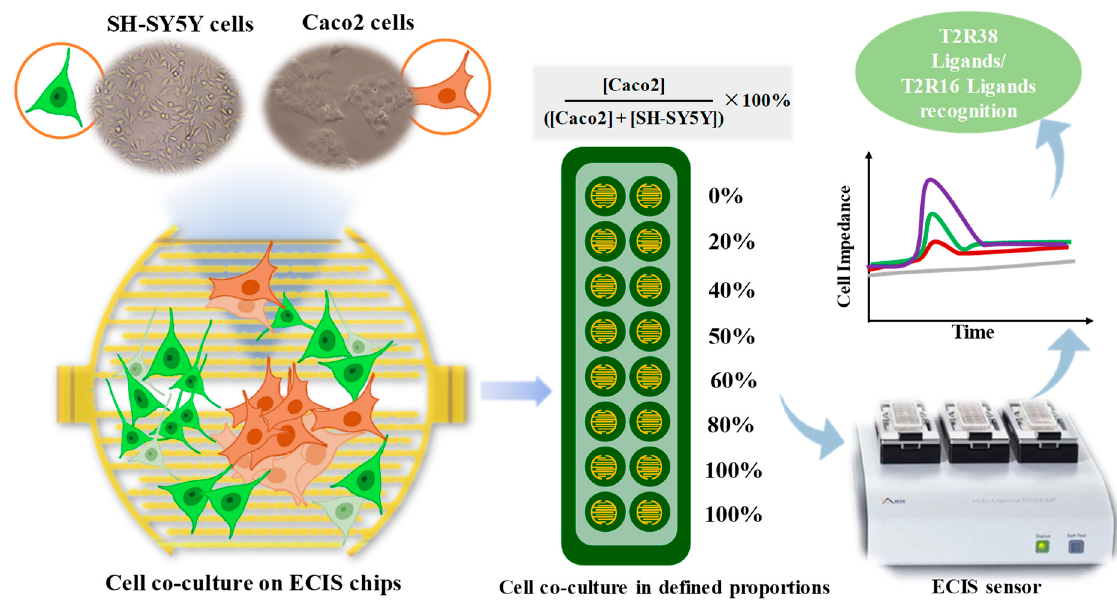
Figure 1. Schematic diagram of cell co-culture taste sensor for bitterness detection .